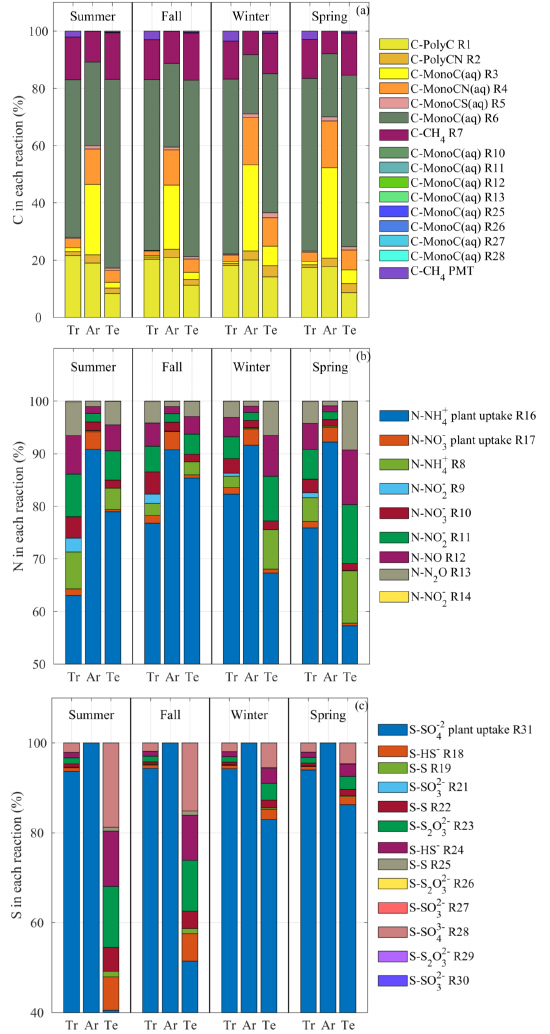
Figure 6. Cumulative carbon ( a ) nitrogen, ( b ), and sulfur ( c ) normalized mass fluxes through the reaction network: R1, depolymerization of organic carbon polymer; R2, depolymerization of organic carbon-nitrogen polymer; R3, aerobic respiration of organic carbon monomer; R4, aerobic respiration of organic carbon-nitrogen monomer; R5, aerobic respiration of organic carbon-sulfur monomer; R6, anaerobic respiration of organic carbon monomer; R7, aerobic CH 4 oxidation; R10, NO − denitrification; R11, NO − denitrification, R12, NO denitrification; R13, N 2 O denitrification; 3 2 R25, S reduction; R26 S 2 O 2 − reduction; R27, SO 2 − reduction; R28, SO 2 − reduction; PMT, the plant 3 3 4 mediated transport; R16, NH + plant uptake; R17, NO − plant uptake; R8, NH + nitrification; R9, 3 4 4 NO − nitrification; R14 chemo-denitrification; R31, SO 2 − plant uptake; R18, HS − oxidation; R19, 2 4 S oxidation; R20, S 2 O 2 − oxidation; R21, S 2 O 2 − oxidation; R22, S oxidation; R23, S 2 O 2 − oxidation; 3 3 3 and R24, HS − oxidation. Refer to Figure S1 and Tables S1–S6 in the Supplementary Information for each reaction code RX and kinetic equation. Tr, Ar, and Te represent tropical, arid, and temperate regions,